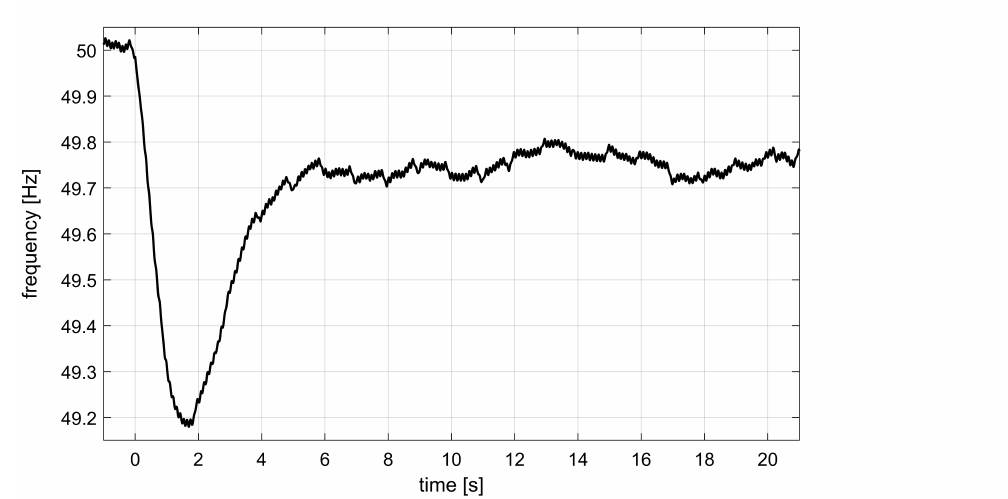
Figure 10. Real controller: frequency response without filters on frequency measurements ( K = 10).